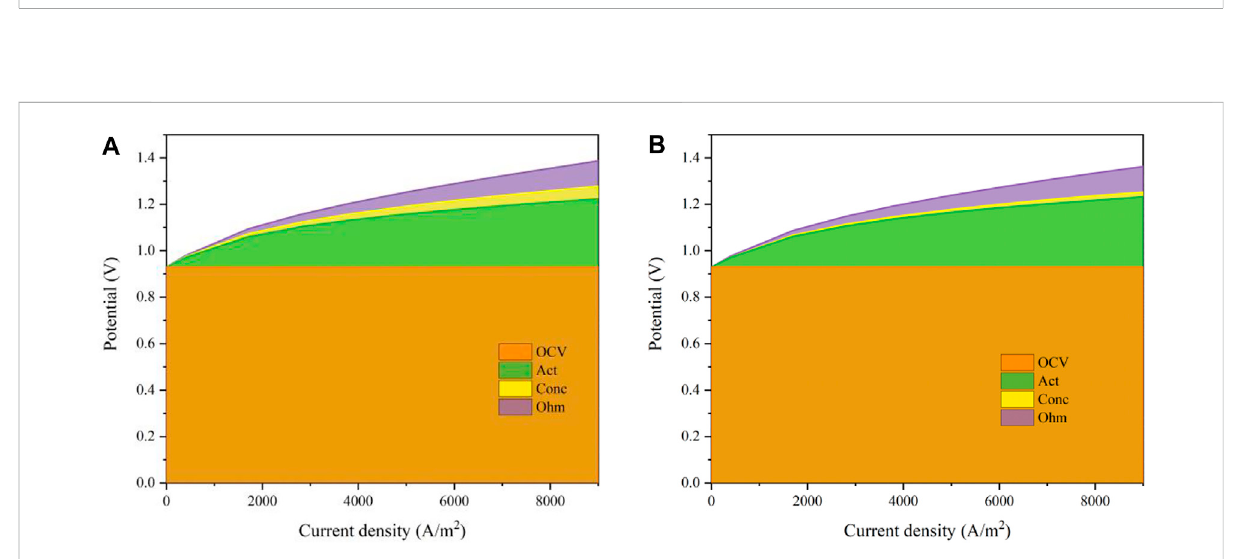
FIGURE 3 Validation of the mathematical model: (A) polarization curve; (B) relative